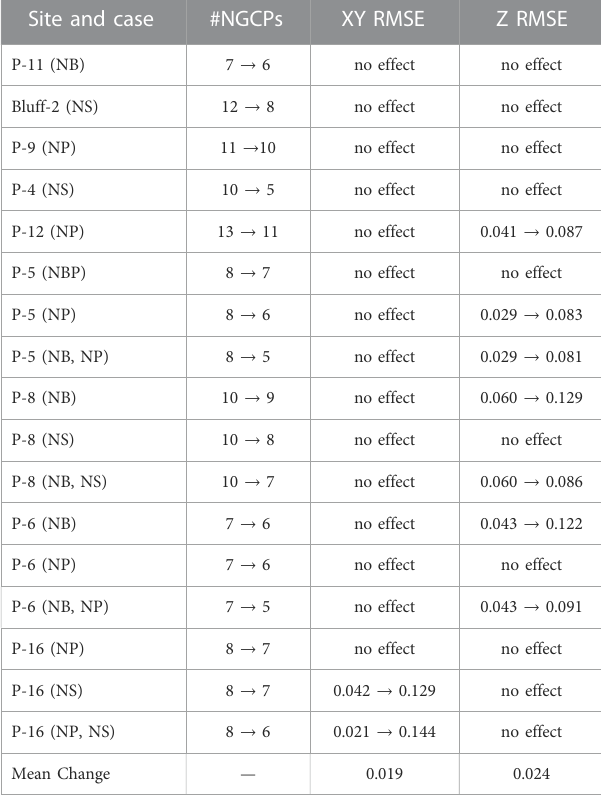
TABLE 2 Effect of removing easily destroyed natural ground control points (NGCPs) on check point horizontal (XY) and vertical (Z) RMSE. Cases of removed NGCPS include no backshore points (NB), no spraypainted points (NS), and no points mounted on metal poles (NP). Changes to RMSE < 0.025 m are noted as “ no effect ” while all other changes are noted as “ original value à new value ” . Mean changes are calculated including the cases where removing points had no effect. All values are shown in